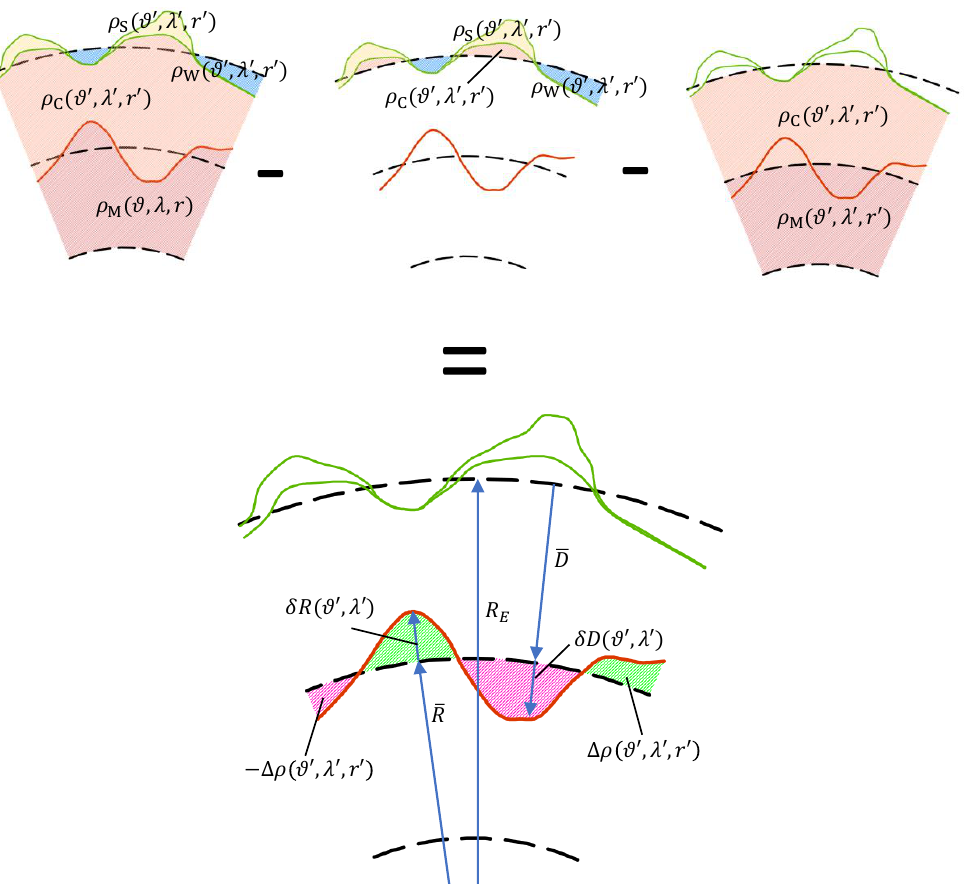
Figure 1. Data reduction to isolate the contribution of the Moho undulation δ R ( ϑ (cid:48) , λ (cid:48) ) . The geom- etry of the problem is depicted on the reduced model. The arrows show the positive direction of each